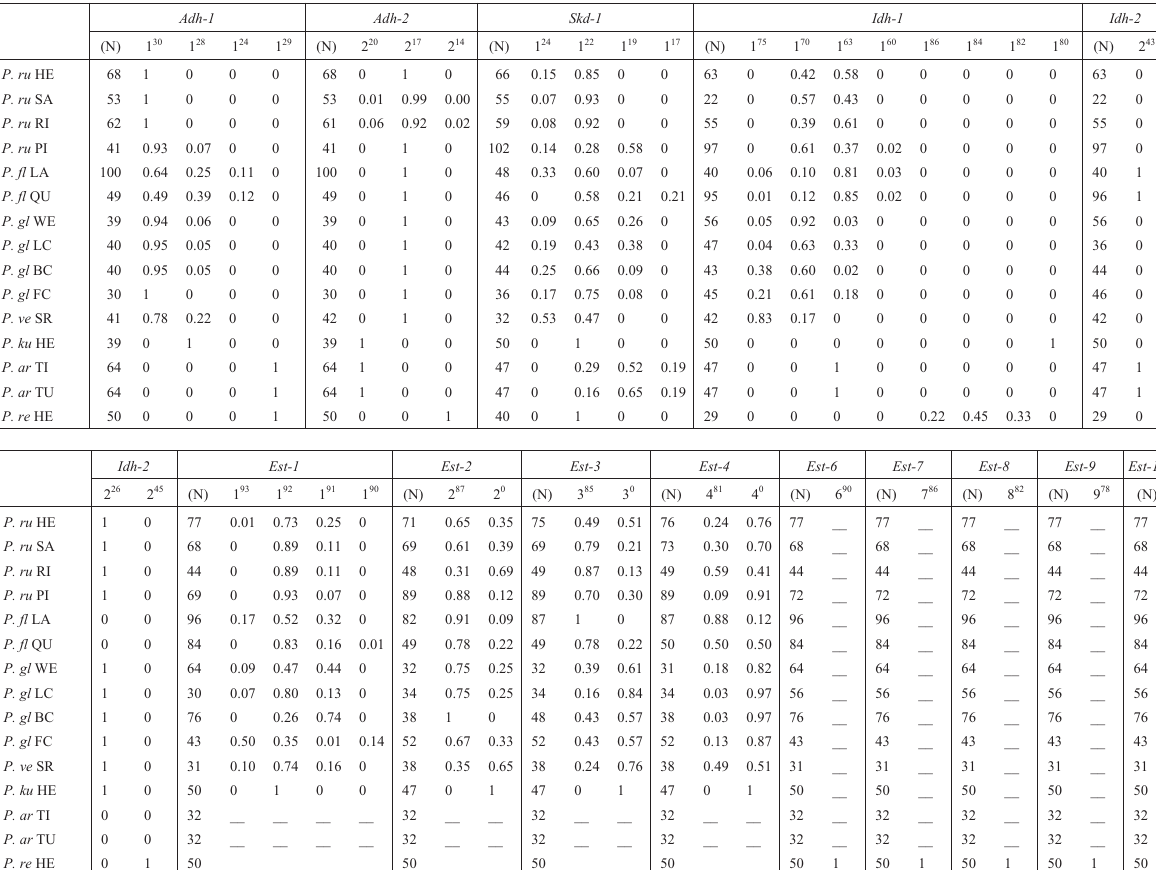
Table 2 - Allelic frequencies and number of seeds analyzed (N) of loci showing variation either within or among populations in the studied species of Prosopis . One additional loci. Amp-1, did not show variation and is not included in the list. Adh-1 Adh-2